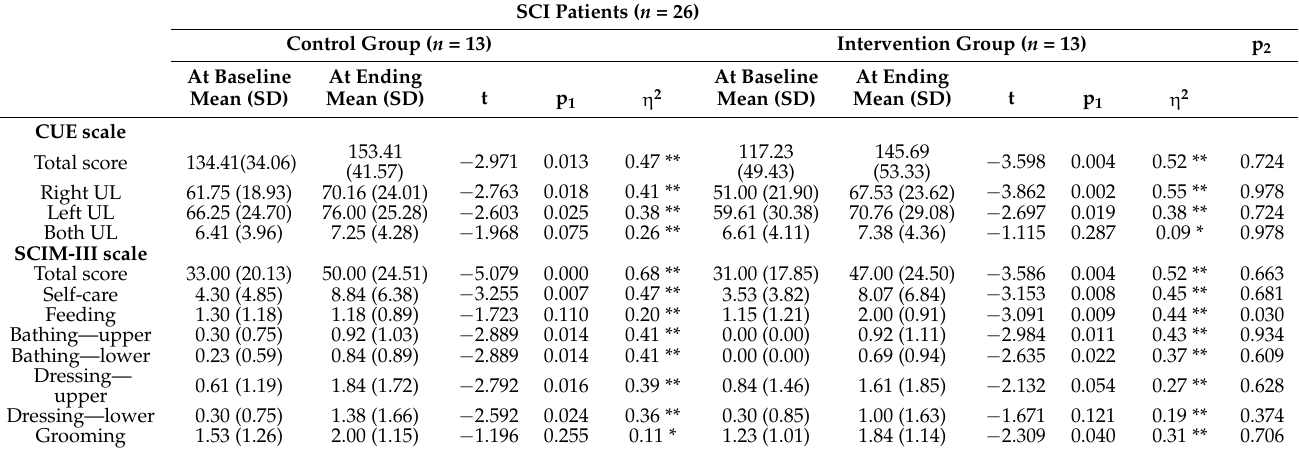
Table 2. Clinical scales at baseline and at the end of the UL treatment for the control and intervention groups.